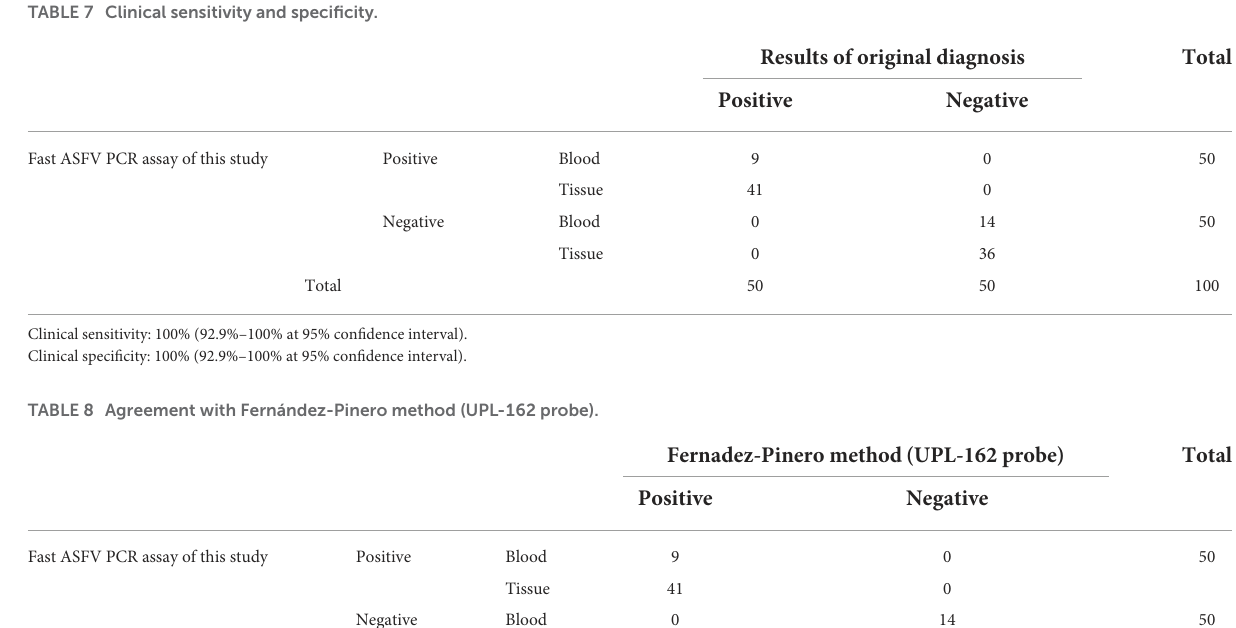
Table 7. The results of the fast ASFV PCR assay of this study show 100% agreement with the original diagnosis results: All 50 positive samples were detected to be positive and all 50 negative samples were detected to be negative. Therefore, it is confirmed that both sensitivity and specificity are 100%.